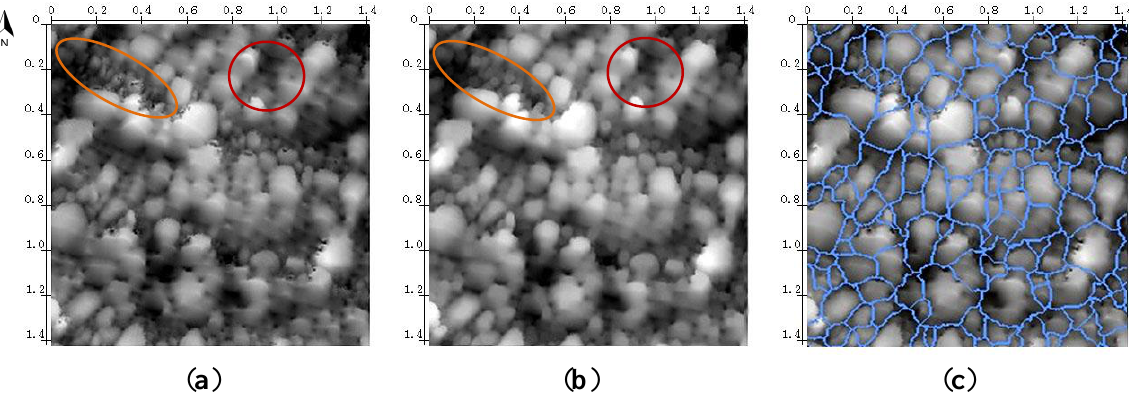
Figure 4. ( a ) Original DSM (3.2 mm resolution), examples of dark holes are marked in